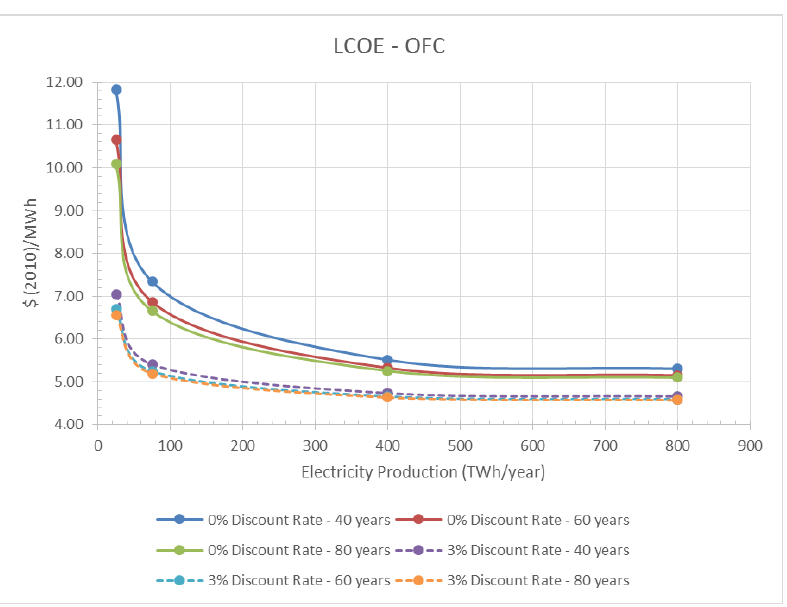
Figure 6. LCOE for OFC.